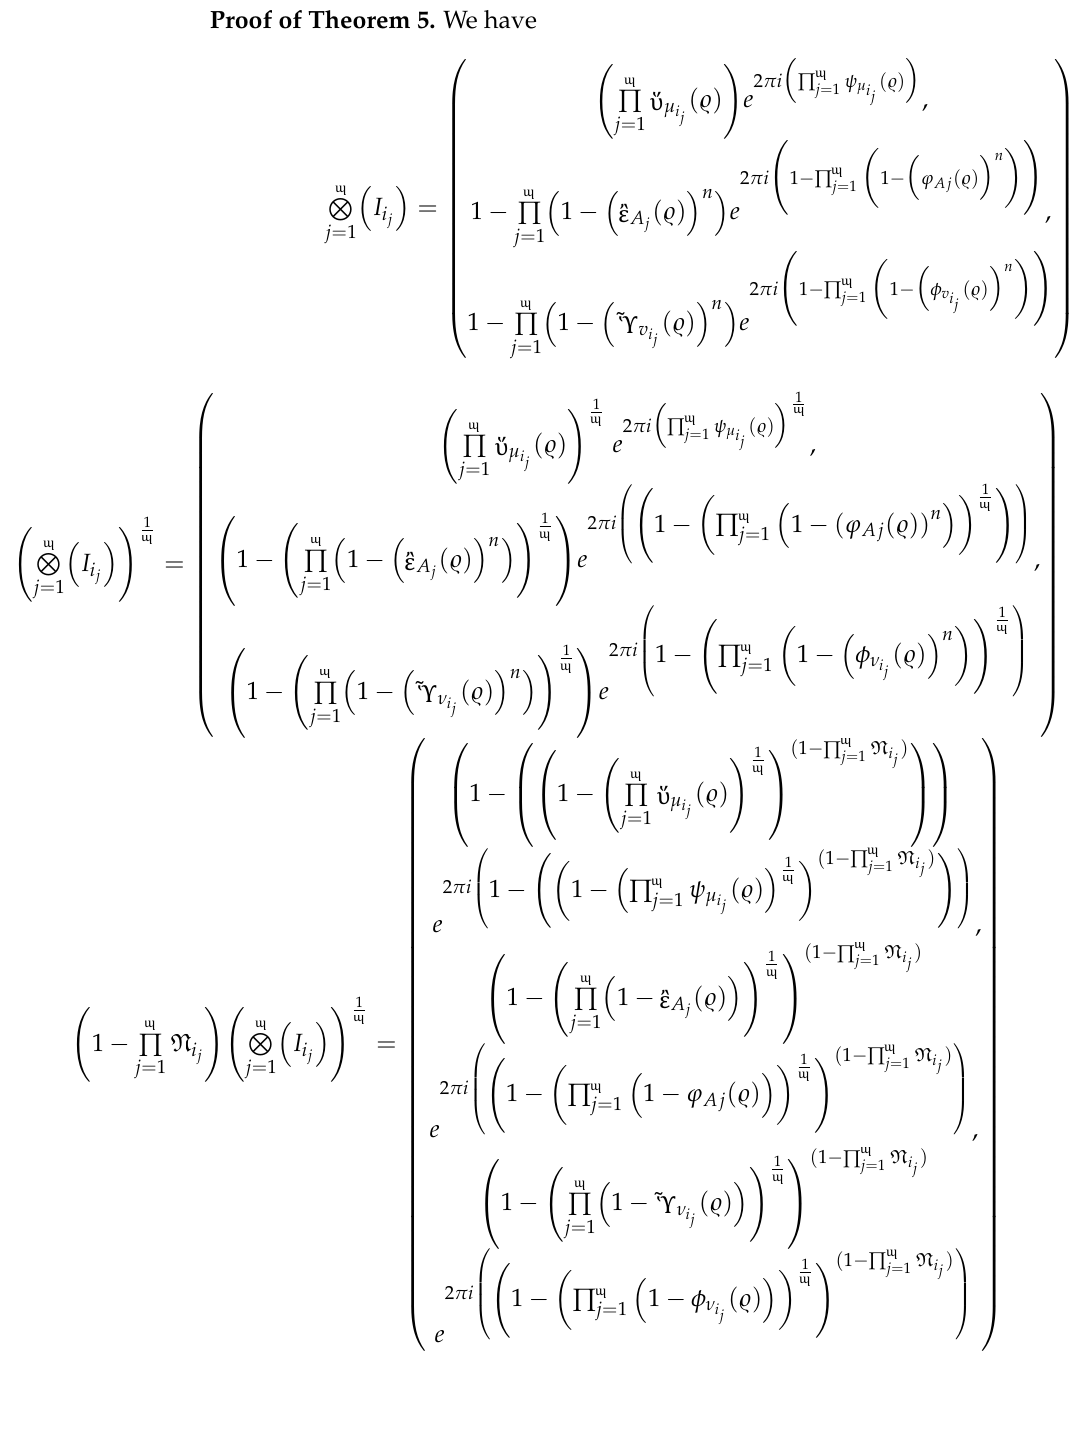
Table 1. Symbols and their